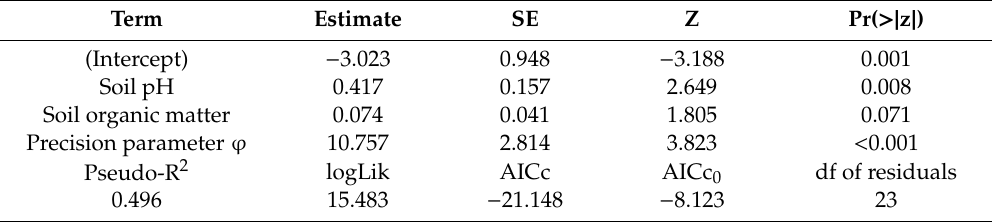
Table 3. Beta regression model of the proportion of moderately and severely damaged Fraxinus excelsior trees within sets of 15 sampled trees per study plot ( n = 27).